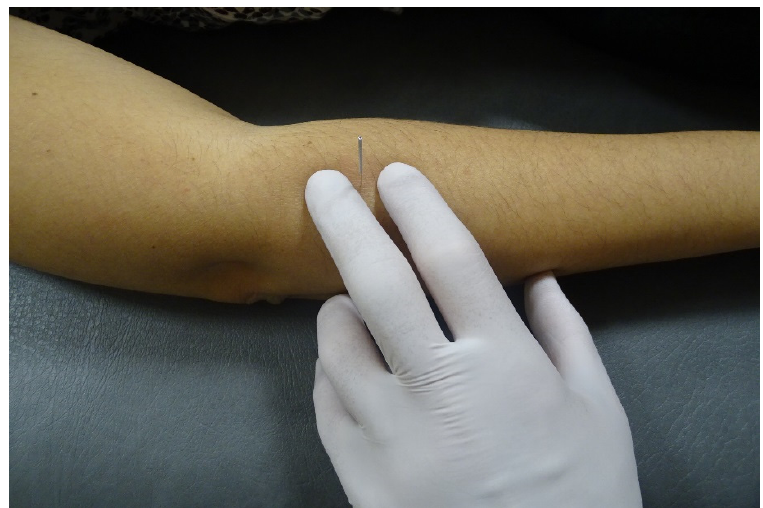
Figure 1. Illustration of needling insertion of the supinator muscle in a living